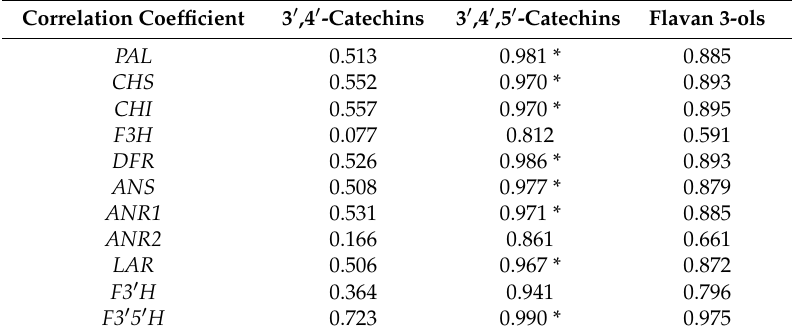
Table 2. The correlation coefficiency between gene expression level and flavan 3-ols.